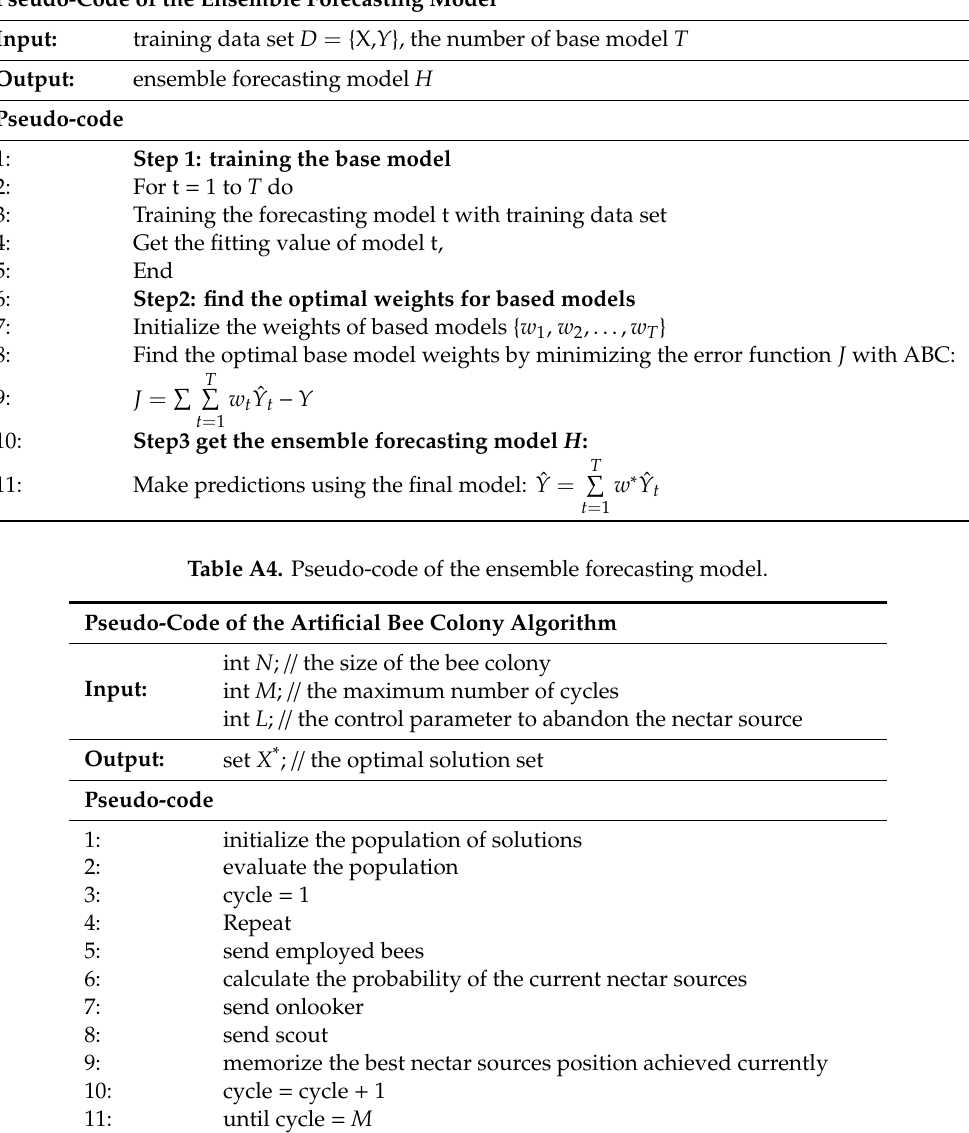
Table A3. Pseudo-code of the ensemble forecasting model. Pseudo-Code of the Ensemble Forecasting Model